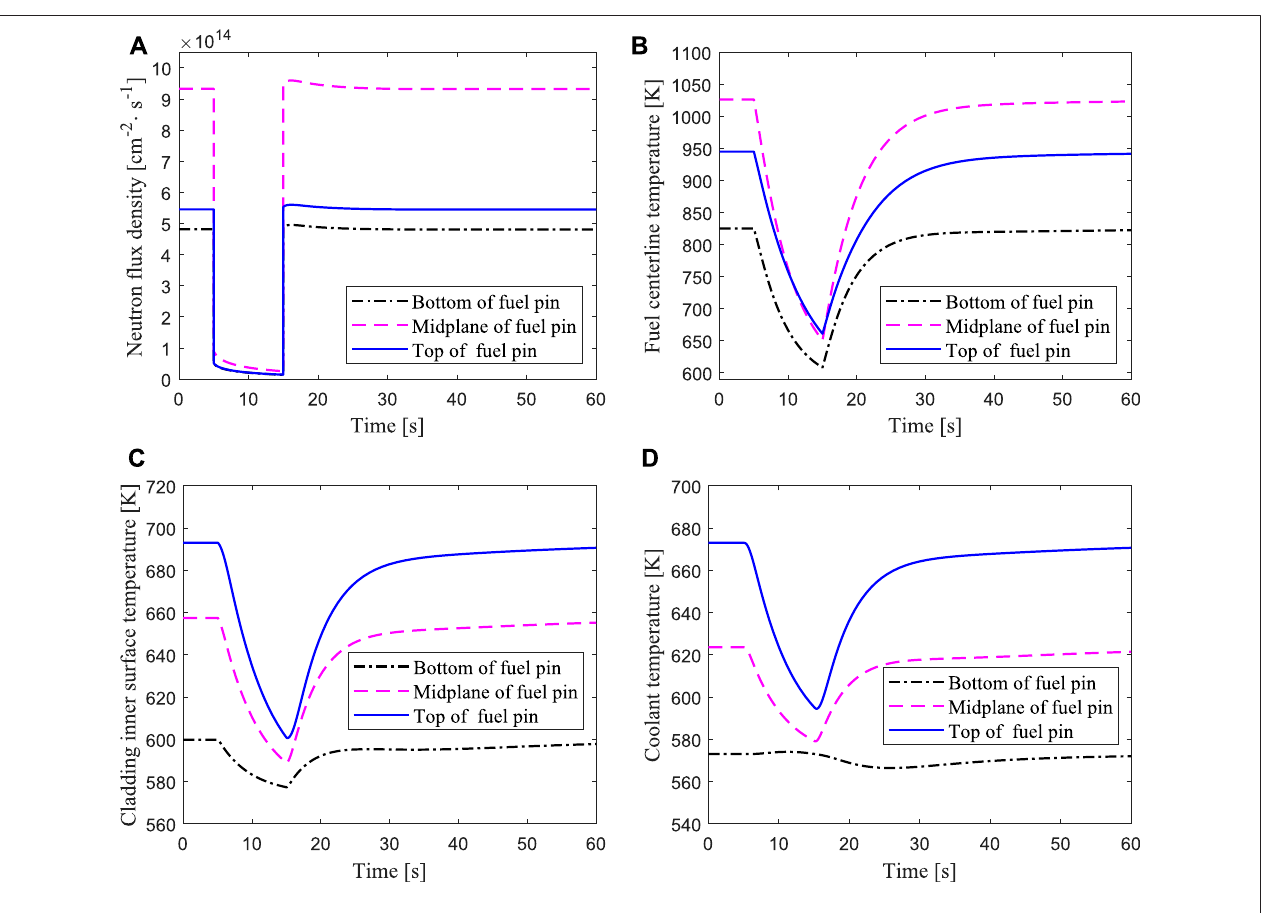
FIGURE 7 | Transient responses of the average channel under beam interruption accident for 10